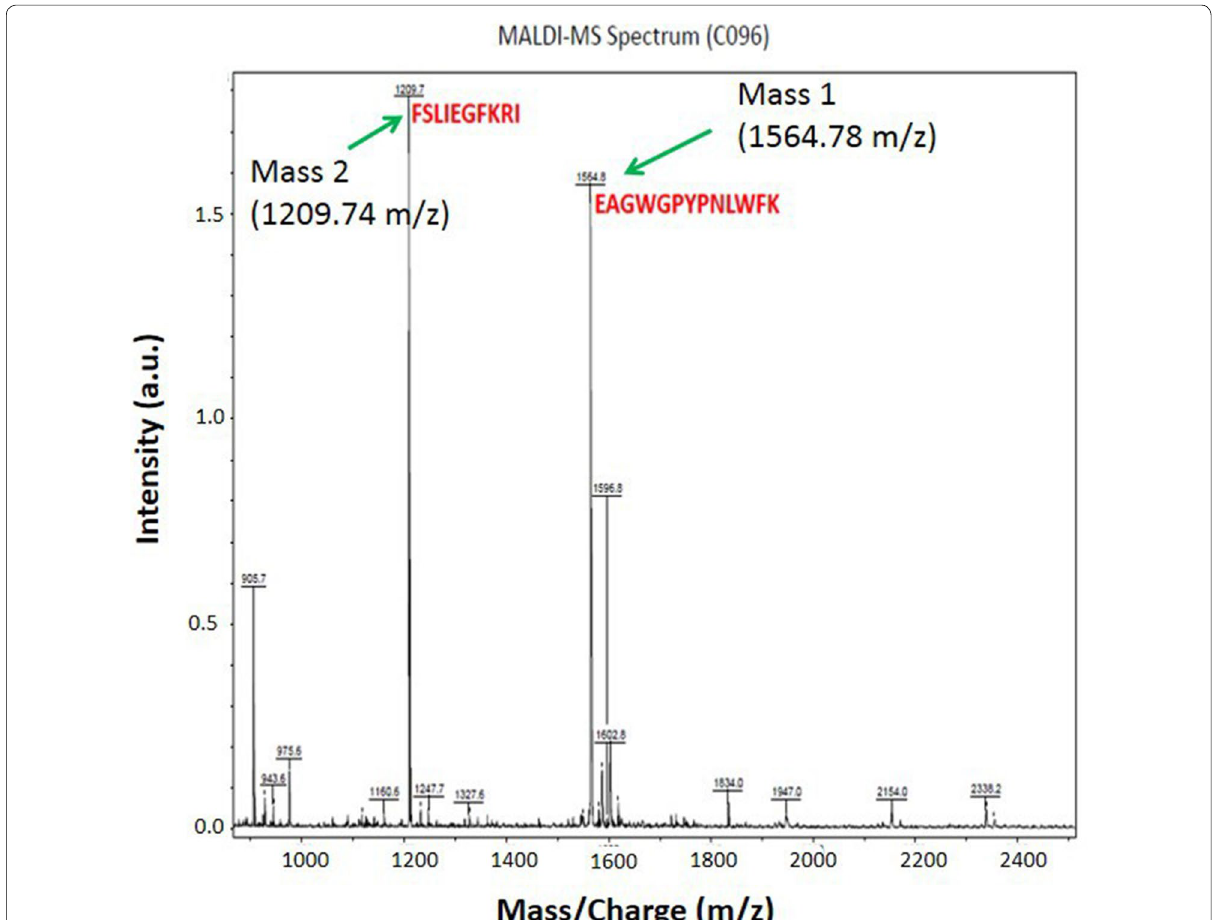
Fig. 4 MALDI–MS spectra of the B. licheniformis QSM eluents obtained by HPLC with the two dominant peaks labelled with the resolved peptide sequence and analytically determined relative molecular